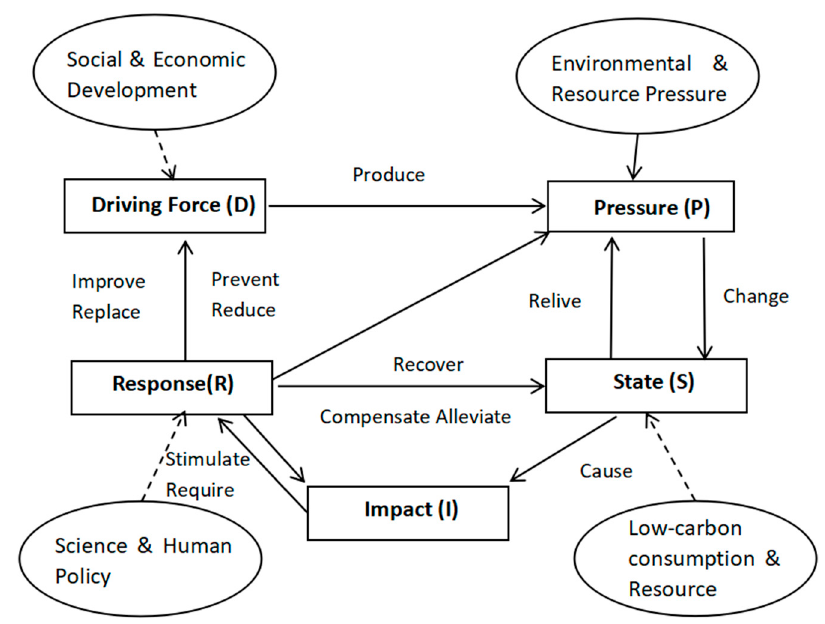
Figure 1. The analytical framework of low-carbon economic system based on driver–pressure–state– impact–response (DPSIR) model.